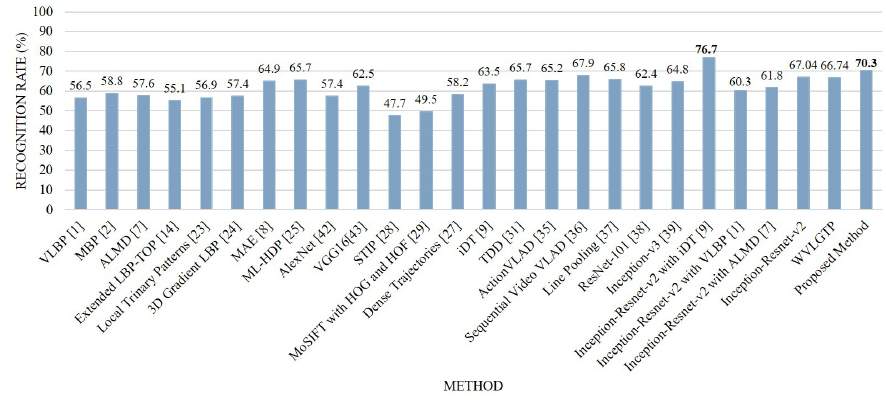
Figure 15. Comparison between the proposed method and other state-of-the-art approaches on the Hollywood2